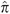
Logistic regression diagnostics plotted against estimated probability of death (π^).The upper left shows the leverage versus π^. The influence diagnostic Δβ^ is plotted versus π^ in upper right panel. We noted two points lie somewhat away from the rest of the data. The lower right panel shows the change in Pearson Chi-square as a function of the estimated probability of death, which is helpful in identifying poorest fit points. In this figure, five points are poorly fitted in the top left and top right corner of the plot (Δχ2>10). The size of the symbol is proportional to Δβ^, allowing us to more clearly ascertain the relative contribution of residual and leverage to Δβ^. The largest circle in the right corner correspond to a moderate leverage and a large Δχ2, indicating that high leverage might not be a contributing factor. The same five points are shown in lower right panel, but note that the range of Δχ2 is much greater than the change in deviance (ΔD). As a result we identified five covariate patterns with large values of ΔD or Δχ2 (poorest fit) and two with outlying values of Δβ^ (largest influence).